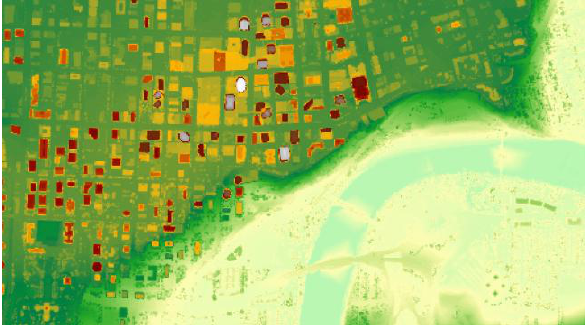
Figure 4. A colour coded digital surface model (red represents high elevations and light blue represents low elevations)